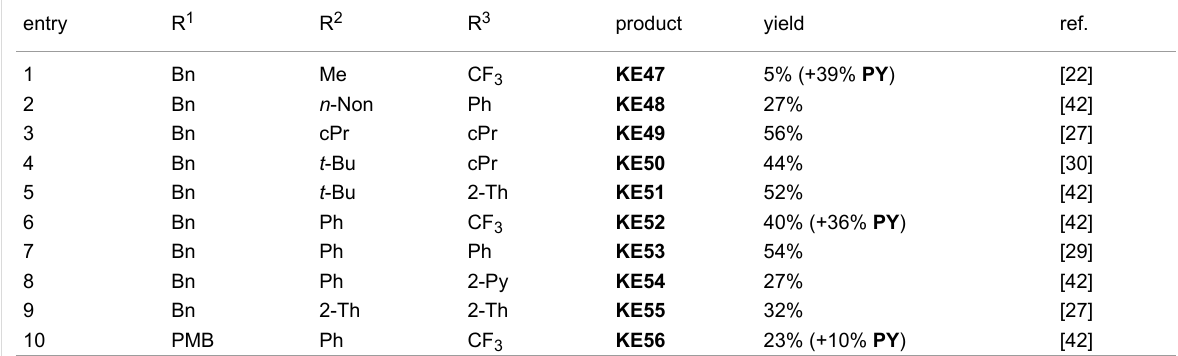
Table 2: Synthesis of β -ketoenamides KE47 – 56 through the LANCA three-component reaction of lithiated benzyloxyallene, nitriles (R 2 -CN) and carboxylic acids (R 3 -CO 2 H) according to Scheme 4. a